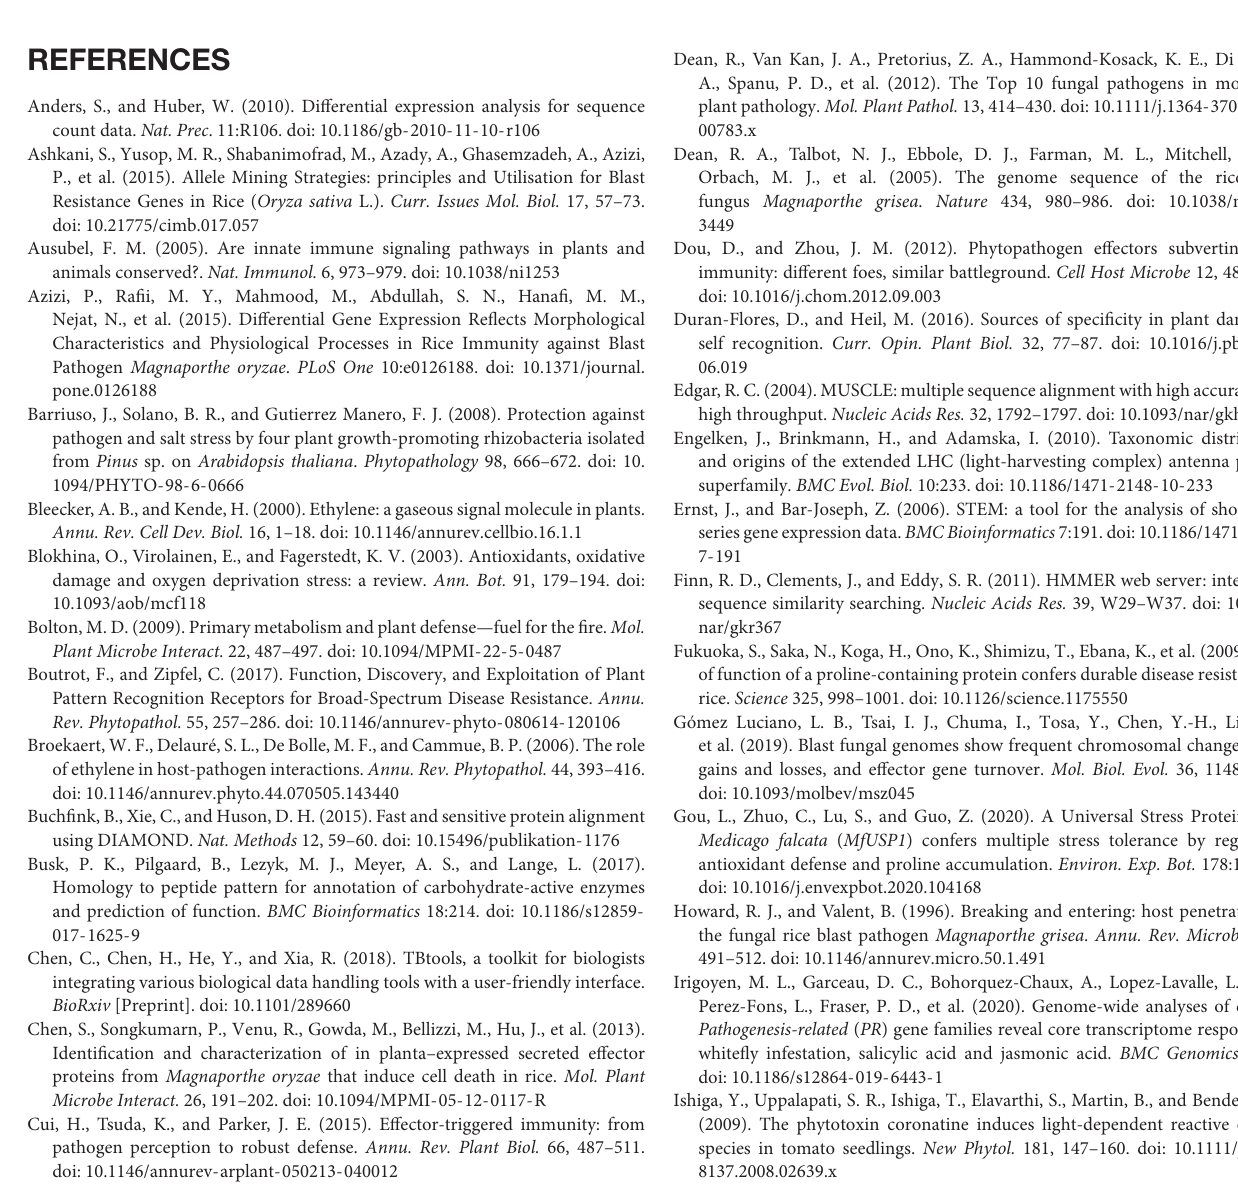
upregulated (red) and downregulated (blue) inoculated leaf samples relative to the control sample are illustrated. Individual genes are represented by small squares. The scale bar displays log2-transformed fold changes. Supplementary Figure 2 | Analysis of O. sativa PR genes relates to CDEGs. (A) Sankey plot depicting association of PR subfamilies and STEM Profiles. (B) RNAseq Expression profiles of O. sativa PR genes assigned into STEM Profile 25, 26, 0, 2, and 6 of co-expression. Supplementary Figure 3 | Diseased reactions of ZH11, OsUSP3 OX , OsUSP4 OX , OsUSP5 OX leaves incubated by M. oryzae 248, 235, and 162. (A) Photographs showing disease reaction of indicated rice lines and races: wild-type (ZH11); overexpression transgenic line of OsUSP4 OX (PXQ4-1, PXQ4-6, PXQ4-14). (B) Disease lesion area was assessed by Image J. Lesions were photographed and measured or scored at 6 days post-inoculation by isolation of M. oryzae 248, 235, and 162. A, B, and C represent the significant differences (one-way ANOVA test, P < 0.01).